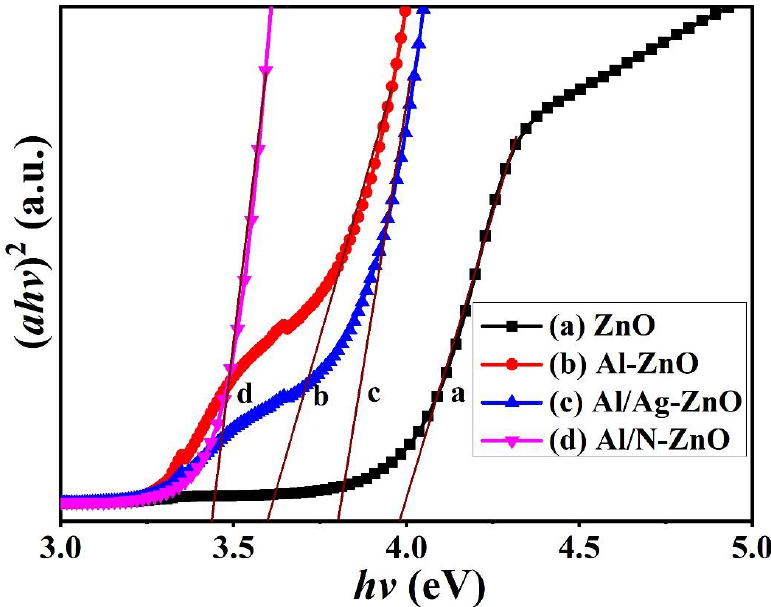
Figure 4. Optical band gap of ZnO (a), metal single doping ZnO (Al-ZnO) (b), metal/metal co-doping ZnO (Al/Ag-ZnO) (c), and metal/non-metal co-doping ZnO (Al/N-ZnO) (d). The brown lines illustrate the method of fitting the linear region to evaluate the band gap at the x-axis intercept.